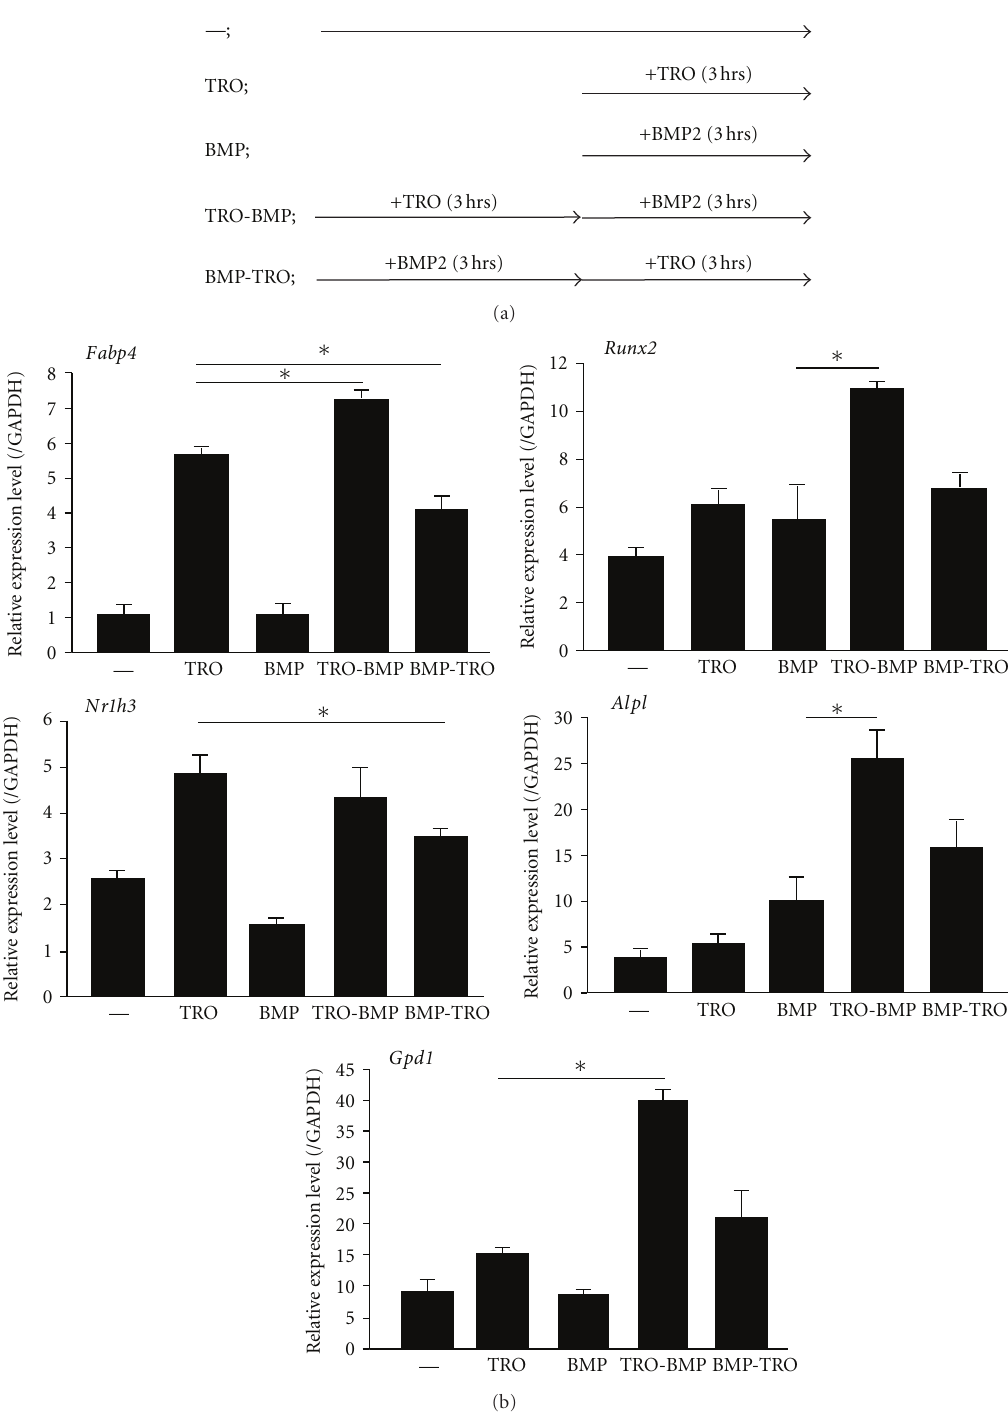
Figure 2: Adipocyte and osteoblast marker gene mRNA levels were altered by changing the order of BMP2 and TRO treatment. (a) Scheme of experiments used in Figures 2 and 3. We examined five conditions. ( - ) Untreated ST2 cells were cultured in α MEM supplemented with 10% FBS and penicillin/streptomycin. (TRO) ST2 cells were incubated with one μ M TRO for three hr. (BMP) ST2 cells were treated with 50ng/mL BMP2 for three hr. (TRO-BMP) ST2 cells were treated with TRO for three hr, the medium was changed, and the cells were then incubated with BMP2 for three hr. (BMP-TRO) ST2 cells were treated with BMP2 for three hr and the medium was changed; the cells were then incubated with TRO for three hr. (b) RT-qPCR analyses of adipocyte or osteoblast di ff erentiation marker genes. After ST2 cells were cultured under the conditions described above, cells were collected and RNAs were extracted. Then RT-qPCR experiments were performed and normalized to Gapdh mRNA. Each experiment was performed at least three times. Student’s t -test was performed. ∗ P < 0 .